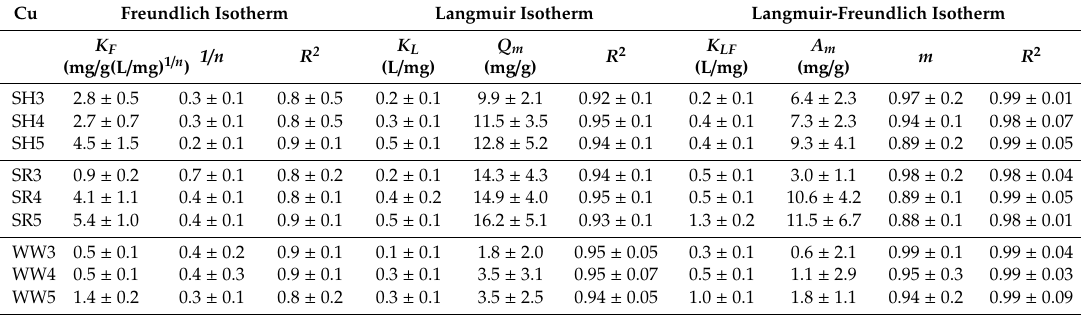
Table 4. Isotherm parameters of the Cu adsorptions on the agricultural biochars with